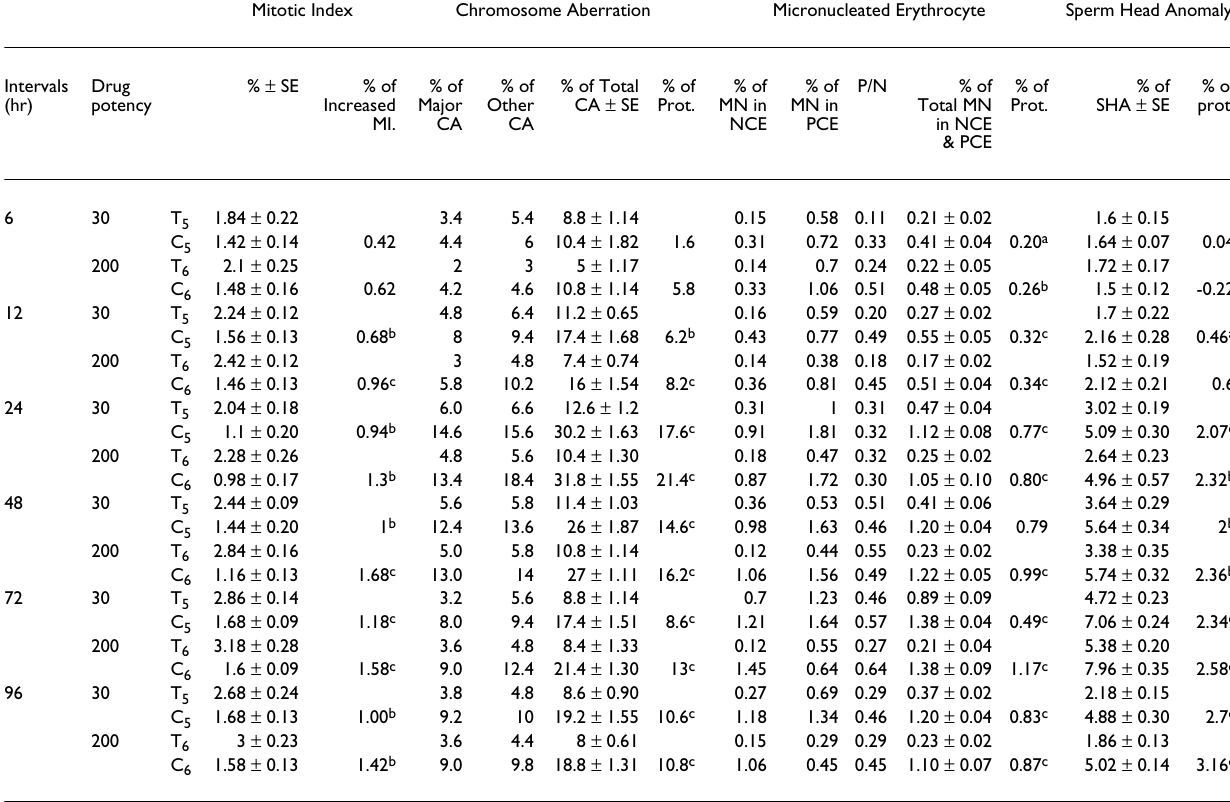
Table 3: Frequency distribution of Chromosome Aberrations (CA) in 500 bone marrow cells examined (100 cells from each